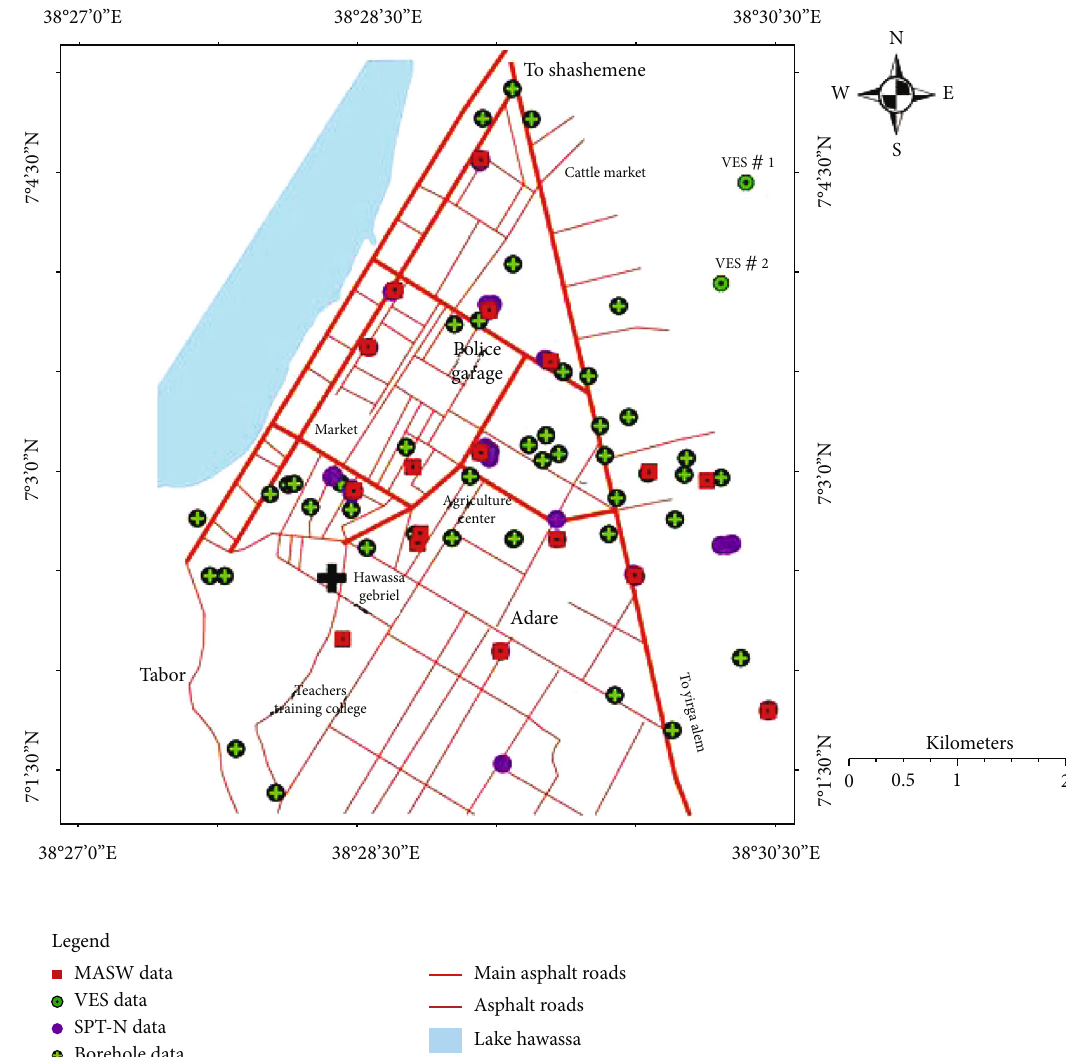
Figure 4: Location of boreholes, SPT-N, MASW, and VES data points in Hawassa